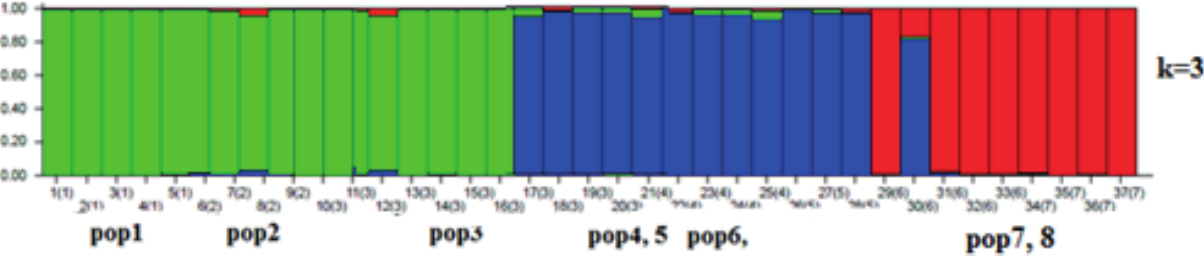
Figure 3. STRUCTURE plot of Pistacia khinjuk populations based on k = 3 of IRAP data. (Population numbers are according to Table